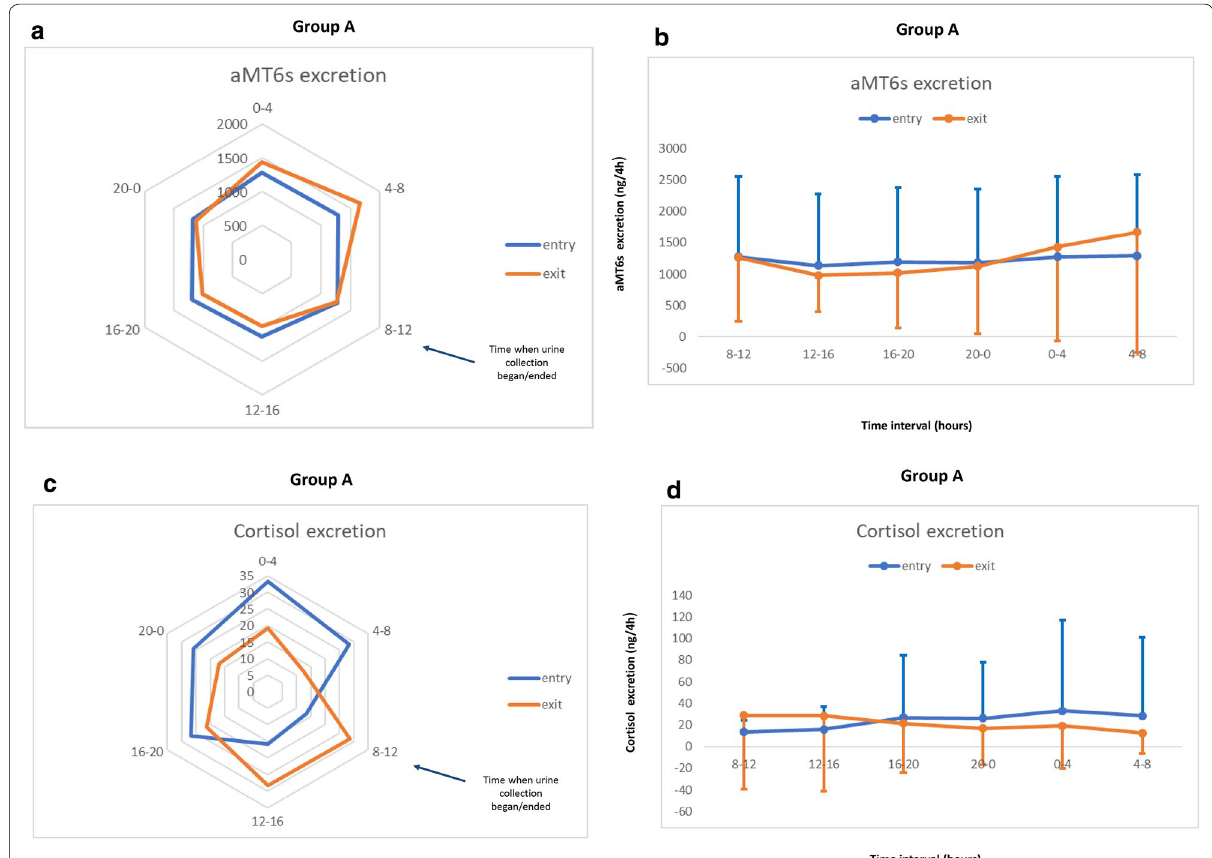
Fig. 2 Radar plots and longitudinal trends of aMT6s and cortisol urine excretion in patients who had septic shock at the time of ICU admission (Group A). a Radar plots of urinary aMT6s excretion mean values (ng) per 4-h intervals upon entry and exit and within a 24-h period in patients who had septic shock at the time of ICU admission ( N 15). The value 0 corresponds to midnight. The blue arrow indicates when urine collection = began/ended for all patients. aMT6s 6-sulfatoxymelatonin. b Longitudinal 24-h profiles of urinary melatonin excretion (aMT6s) mean values per = 4-h intervals upon entry and exit in patients who had septic shock at the time of ICU admission. Error bars represent standard deviations (SDs). The value 0 on x axis corresponds to midnight. c Radar plots of urinary cortisol excretion mean values (ng) per 4-h intervals upon entry and exit and within a 24-h period in patients who had septic shock at the time of ICU admission. The value 0 corresponds to midnight. The blue arrow indicates when urine collection began/ended for all patients. d Longitudinal 24-h profiles of urinary cortisol excretion mean values per 4-h intervals upon entry and exit in patients who had septic shock at the time of ICU admission. Error bars represent standard deviations (SDs). The value 0 on x axis corresponds to